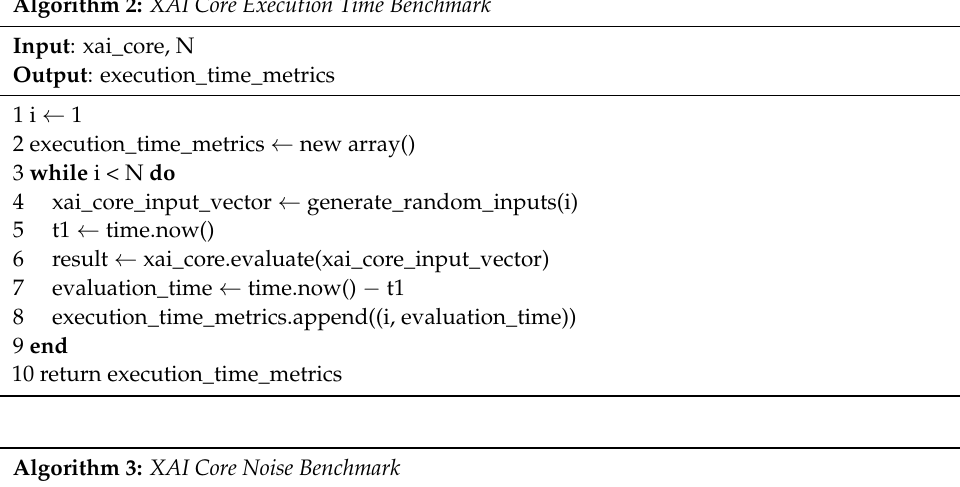
Algorithm 3: XAI Core Noise